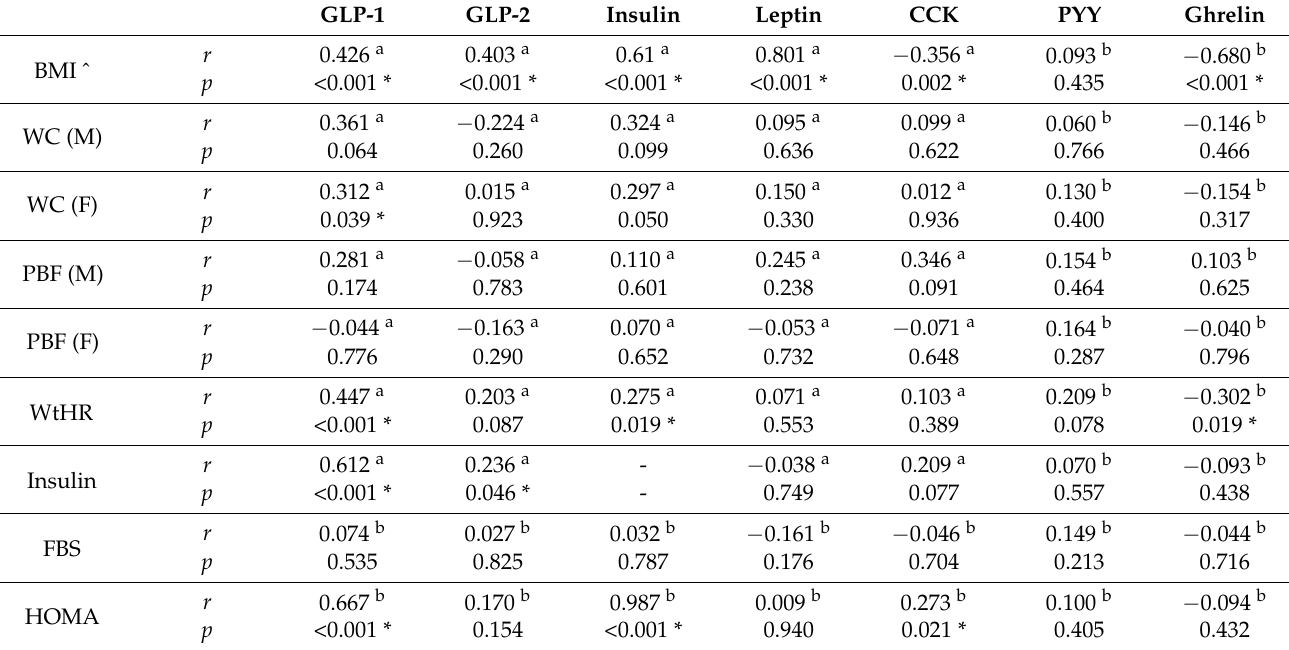
Table 3. Partial correlations, adjusting for BMI, between peptide hormones and markers of obesity and